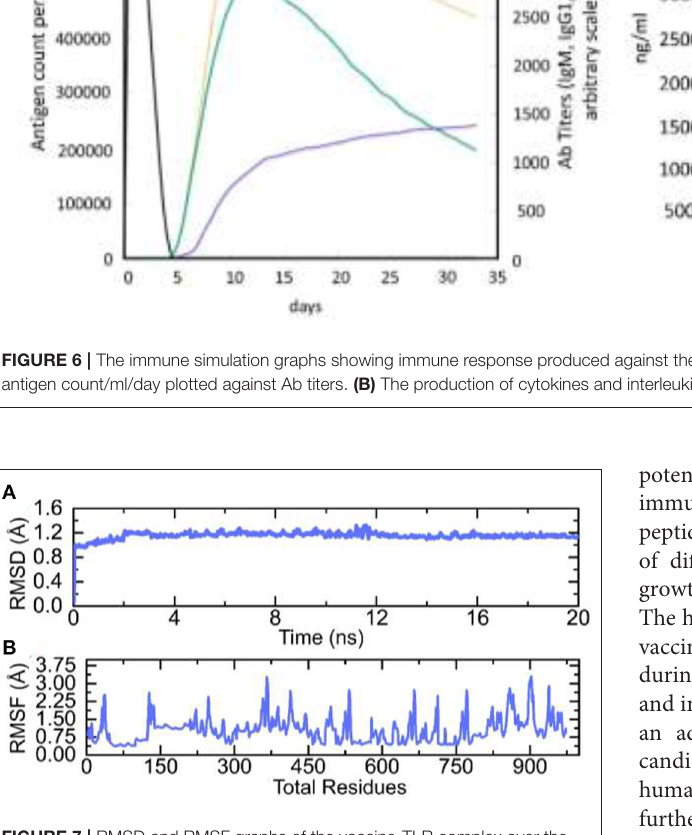
FIGURE 7 | RMSD and RMSF graphs of the vaccine-TLR complex over the simulation time. (A) RMSD and (B) RMSF of the